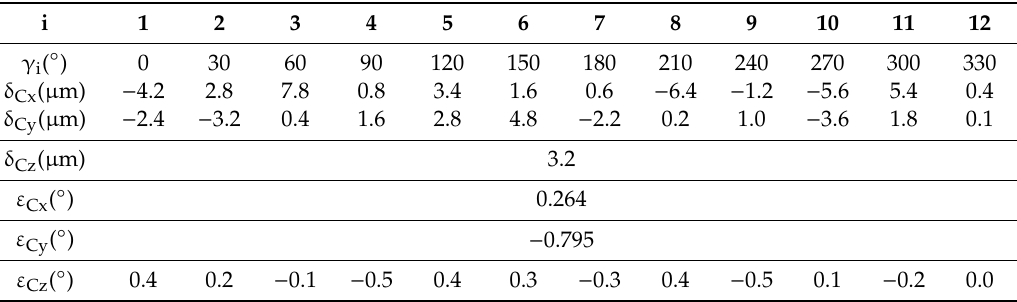
Table A6. Complete geometric errors of the